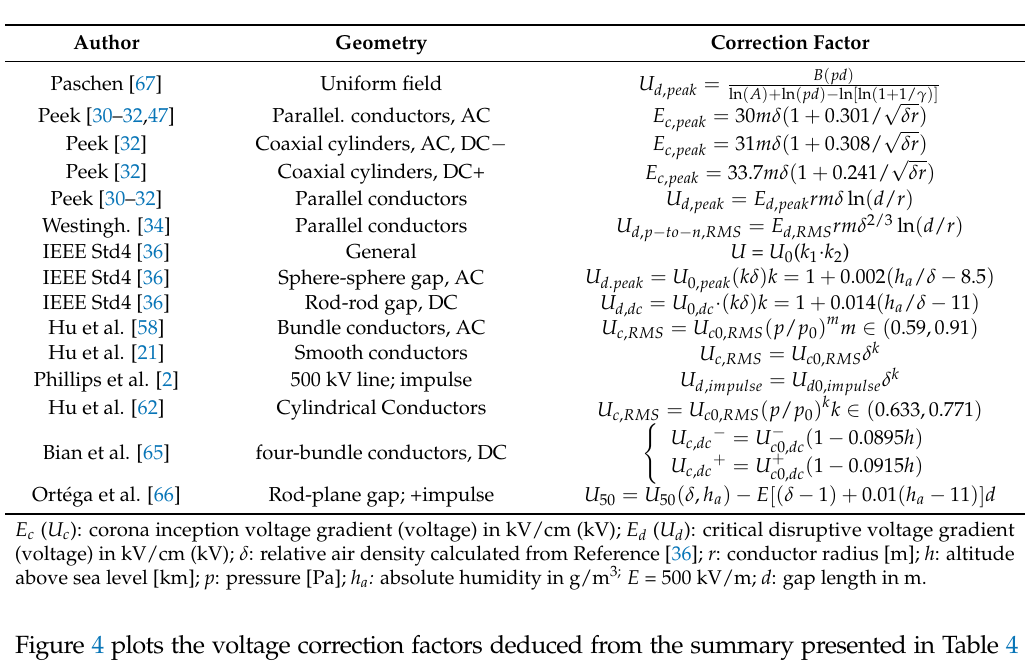
Table 4. Summary of Correction Factors.